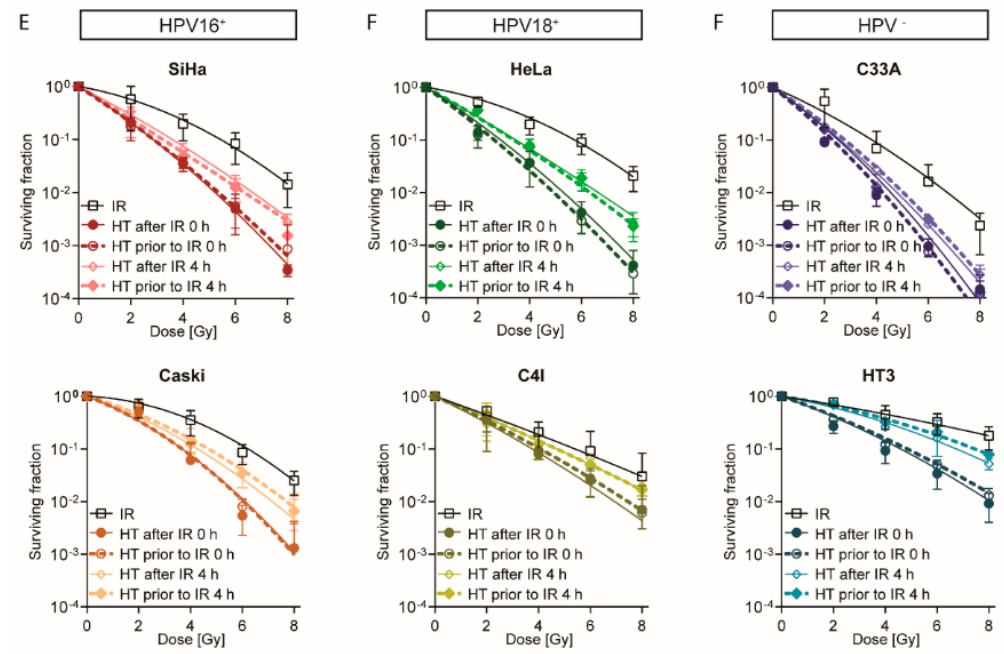
Figure 1. A short time interval between ionizing radiation and hyperthermia decreases cell survival. To study the effect of time interval (0, 2, or 4 h) between ionizing radiation (IR) and hyperthermia (HT), clonogenic assays were performed for six cervical carcinoma cell lines. ( A ) Schematic overview of applied treatments. ( B – D ) Survival fraction is demonstrated in heat maps: (B) HPV16 + cell lines SiHa and Caski, (C) HPV18 + cell lines HeLa and C4I, and (D) HPV-negative cell lines C33A and HT3—a darker color indicates lower cell survival. Per heat map, from top to bottom, different doses (2, 4, 6, and 8 Gy) of ionizing radiation are presented. Within one dose of ionizing radiation, cells treated with different temperatures of hyperthermia (37, 39, 41, and 42 °C). From left to right, within one heat map the left side shows results for hyperthermia applied before ionizing radiation with 0, 2, and 4 hour time interval, while on the right side ionizing radiation was applied before hyperthermia. Means of